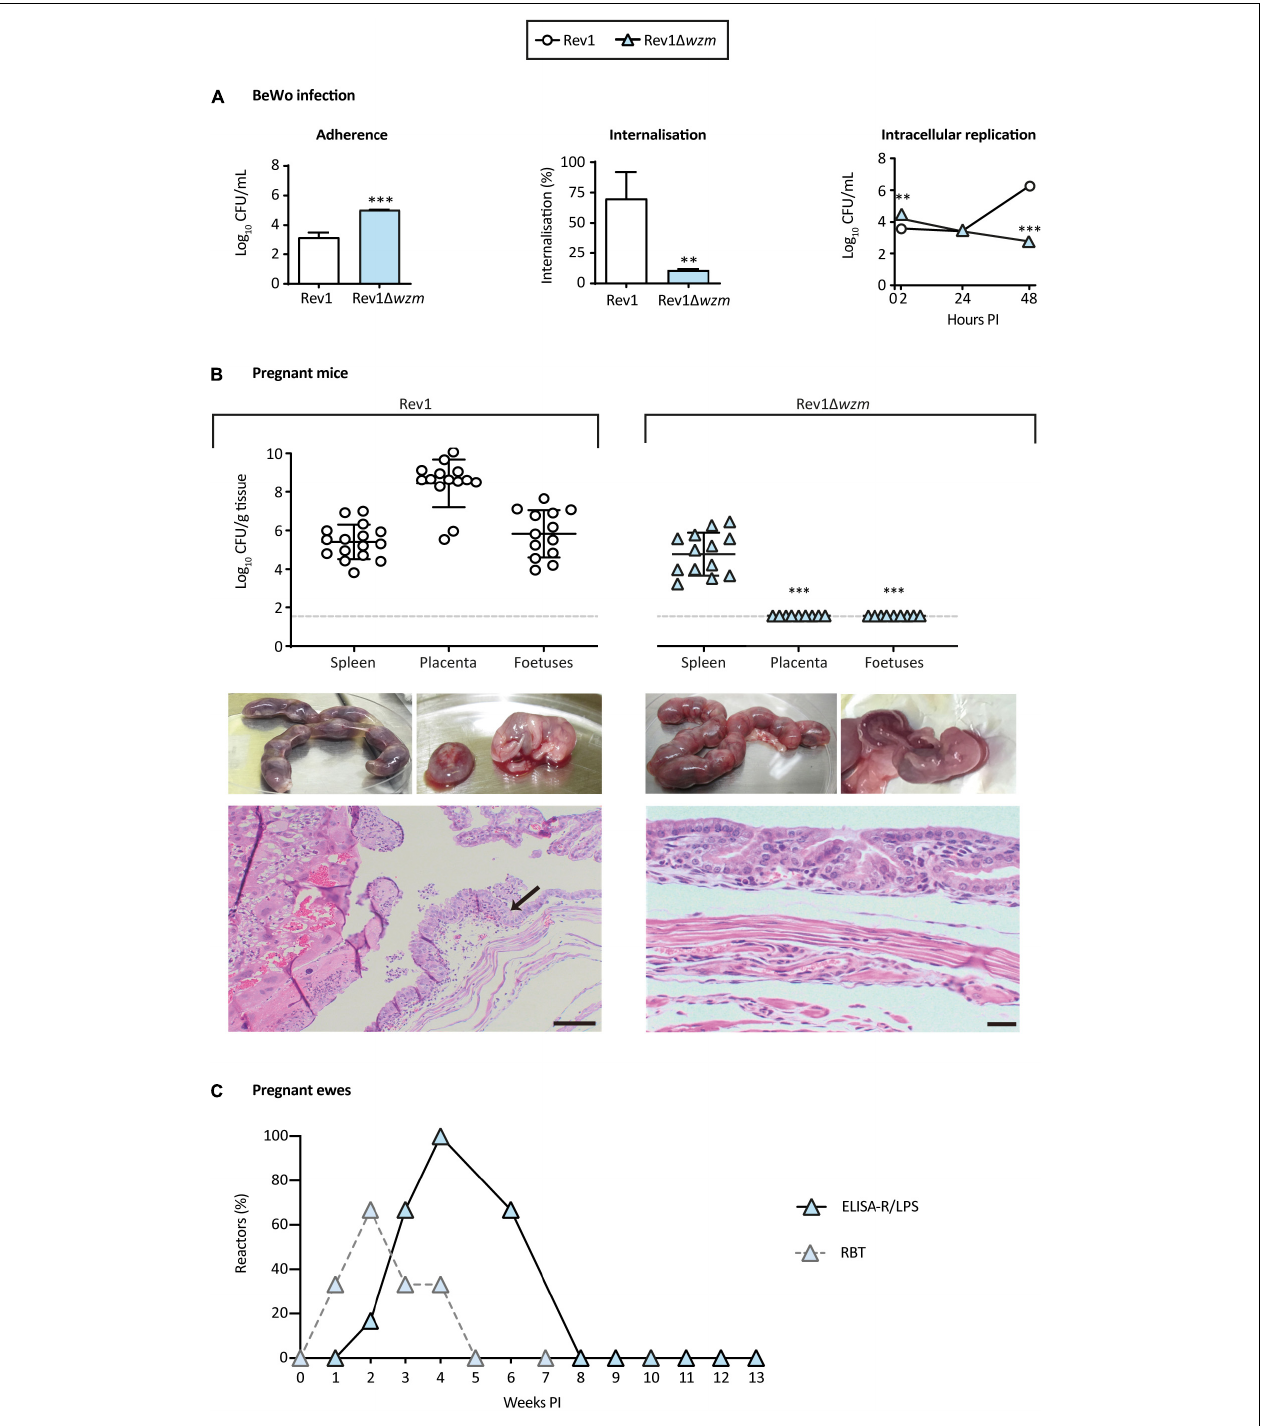
FIGURE 8 | Rev1 (cid:49) wzm is attenuated in BeWo cells, safe in pregnant mice, and induces minimal serological interference in ewes vaccinated at mid-pregnancy. (A) Adherence, internalization, and intracellular multiplication in BeWo cells ( n = 3). (B) Bacteriology of spleens (upper panel), as well as macroscopic and microscopic representative images of placentas and fetuses from the pregnant CD1 mice, analyzed at 14 days after IP inoculation with 1 × 10 7 CFU of Rev1 (cid:49) wzm ( n = 14; the right column) or 1 × 10 6 CFU of Rev1 ( n = 16; the left column). The arrow indicates leukocyte infiltration; scale bars = 100 µ m. Detection limit (log 10 33 CFU/g tissue = 1.52) is indicated with a discontinuous line. In panels A,B , results are presented as mean ± SD of the correspondent n value. (C) Serological response (% reactors) in ewes vaccinated SC with 1.8 × 10 10 CFU of Rev1 (cid:49) wzm at mid-pregnancy, developing antibodies in ELISA-R/LPS and RBT. Fisher’s LSD or t -tests; ∗∗∗ p ≤ 0.001, ∗∗ p ≤ 0.01 vs. Rev1